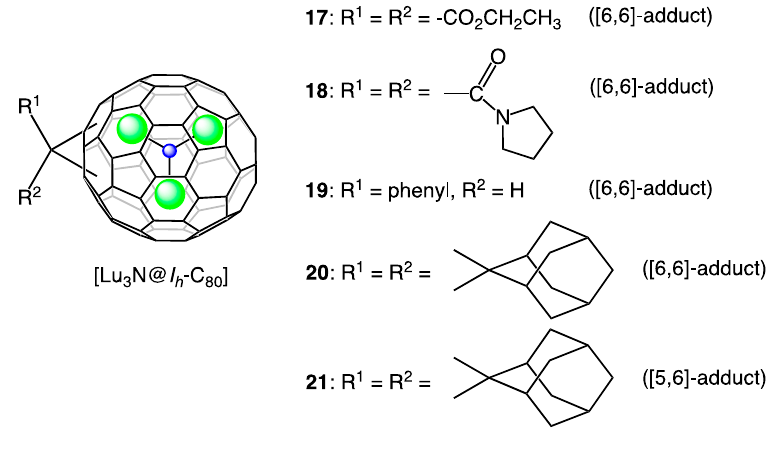
Figure 6. Structures of 17 – 21 .